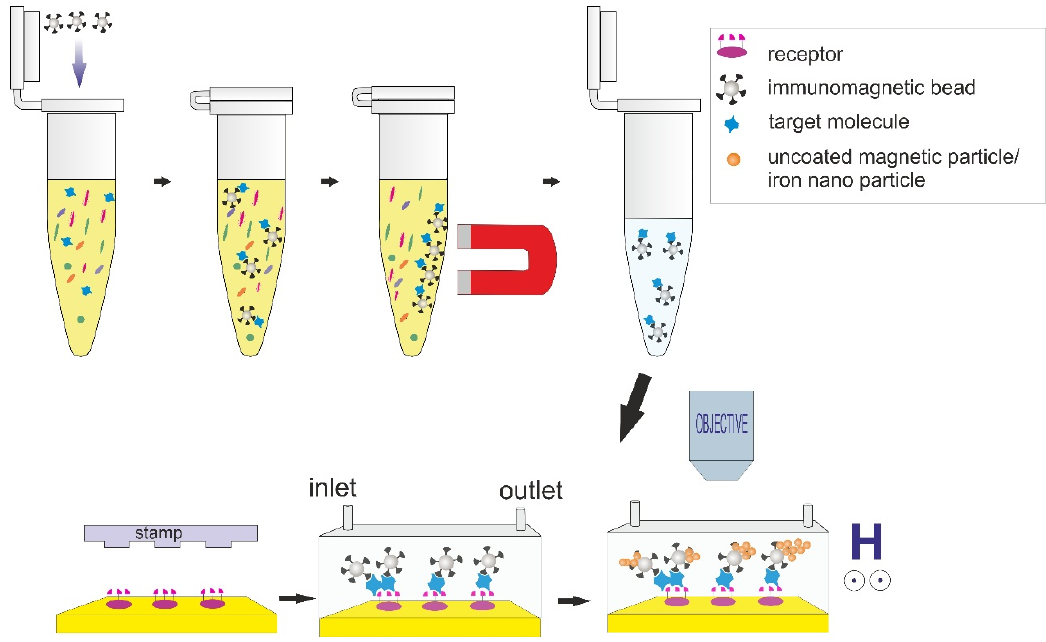
Figure 2. Schematic of the complete biosensing experiments: streptavidin was used as the target molecule, biotin ‐ coated beads captured and separated the target, signal amplification occurred in the microfluidic chamber using iron nano particles.